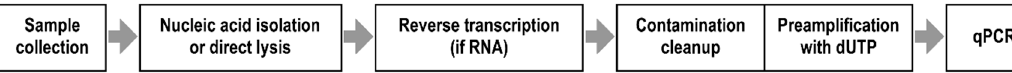
Figure 1. An experimental workflow. Contamination cleanup with Cod uracil-DNA